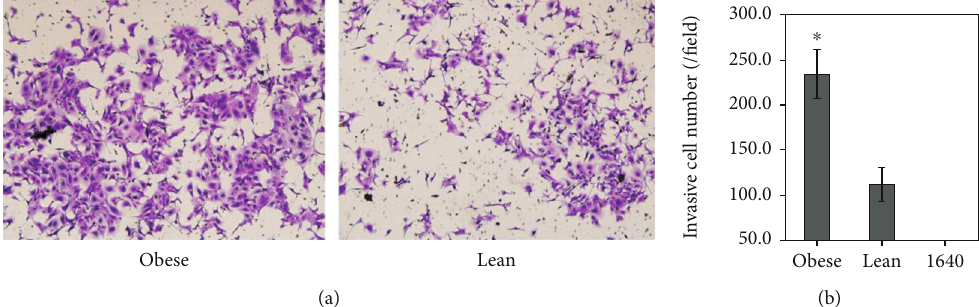
Figure 7: E ff ects of obesity on TE-1 cell invasion. Obesity accelerated signi fi cantly TE-1 cell invasion than the lean ( 234 : 0 ± 26 : 9 versus 112 : 4 ± 18 : 9 / fi eld, ∗ P < 0 : 001 ). Magni fi cation, ×